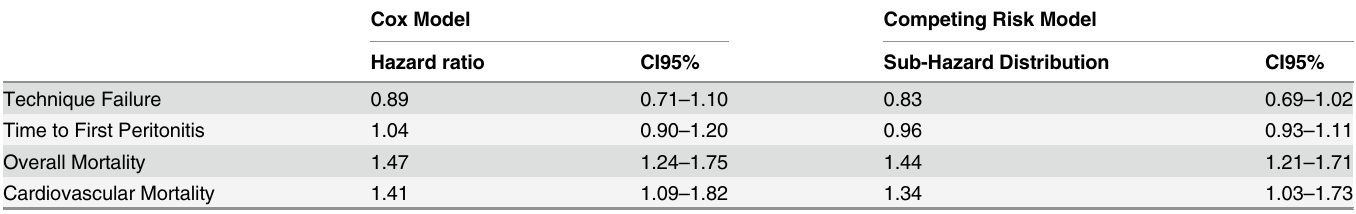
Table 2. Determinants of Clinical Outcomes taking CAPD as the